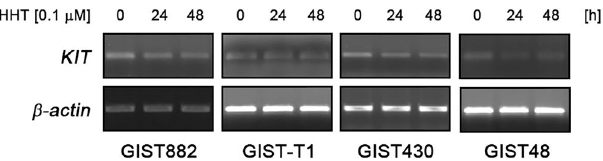
Figure 4. KIT mRNA levels are not affected by HHT treatment. KIT mRNA expression (RT-PCR) after treatment of GIST cells with DMSO or 0.1 μM HHT for the indicated times. β-actin mRNA expression (RT-PCR) serves as loading